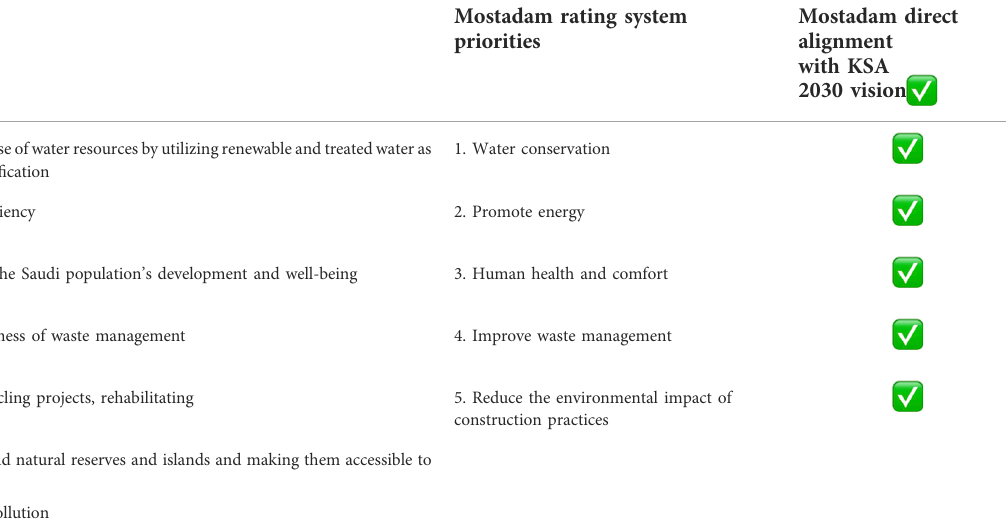
TABLE 2 A table comparing the main elements of KSA ’ s 2030 vision and Mostadam (Mostadam Rating System, 2020) and (Dynamo Visual Programming,